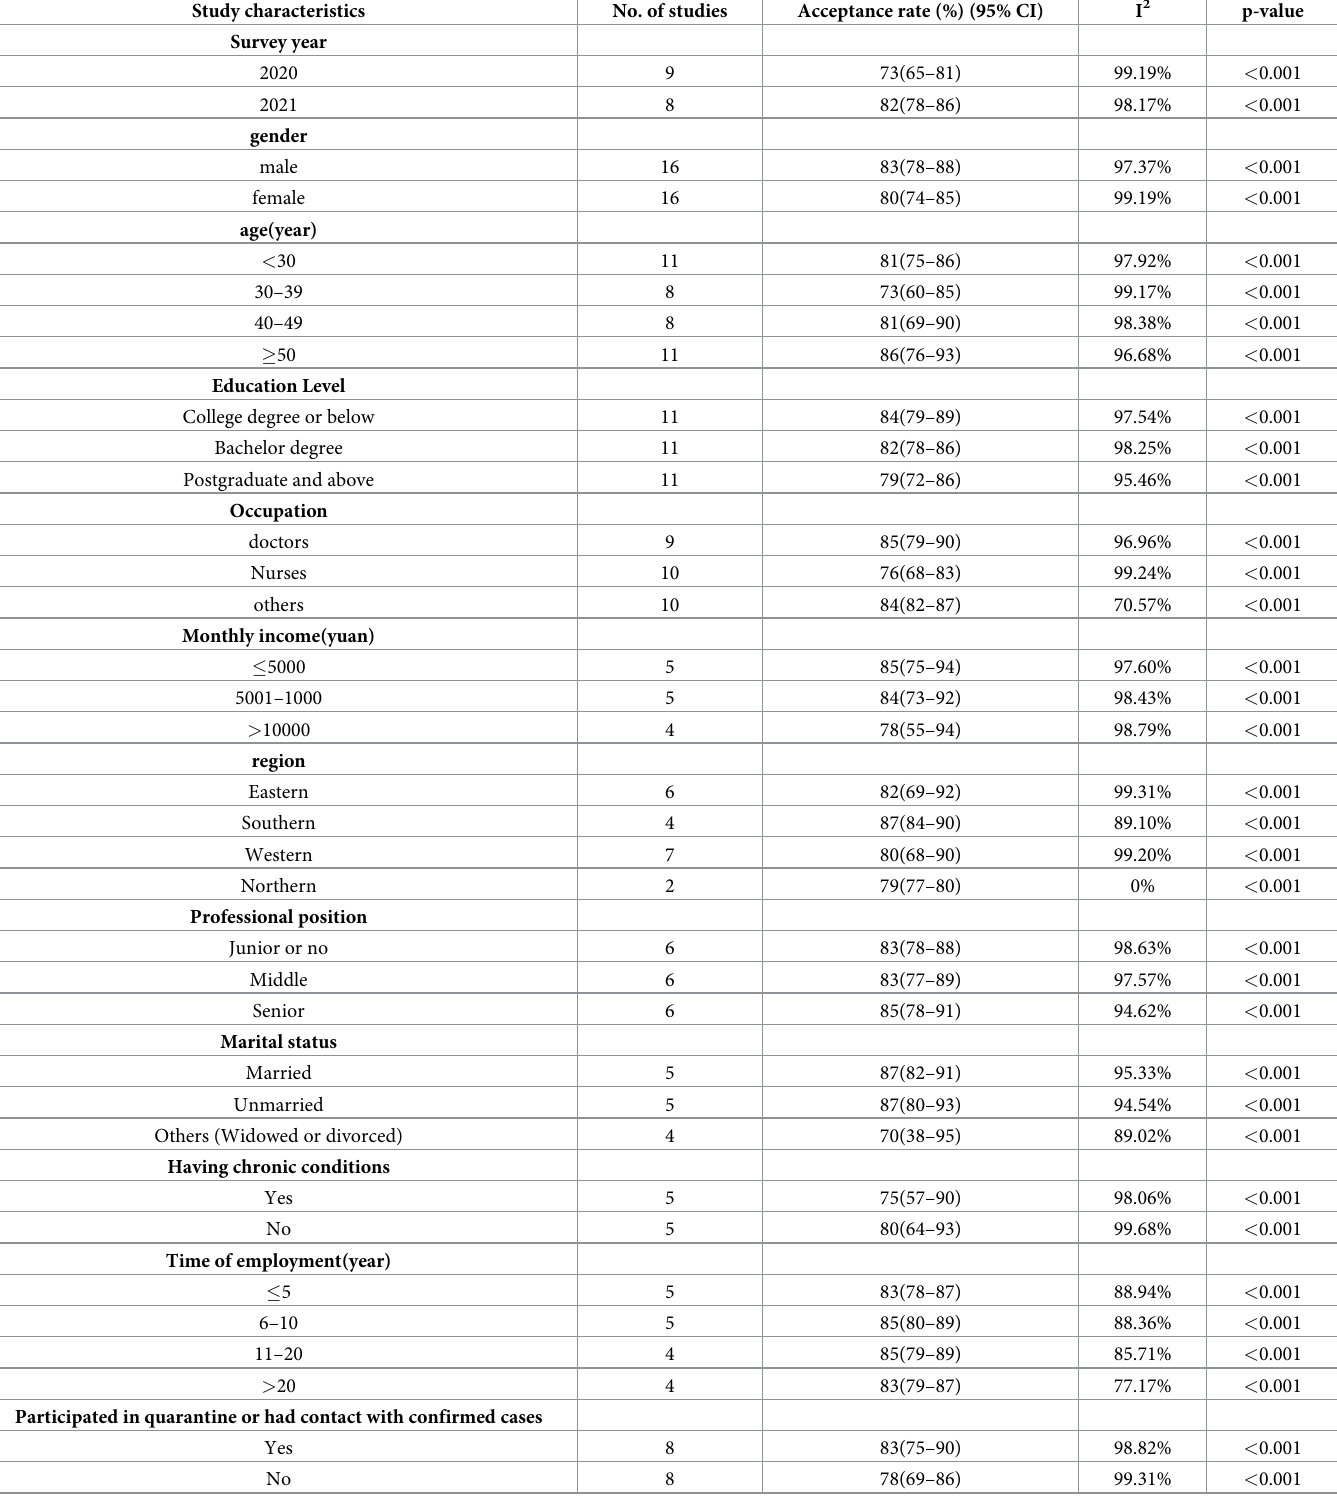
Table 2. Subgroup analysis based on the characteristics of the included